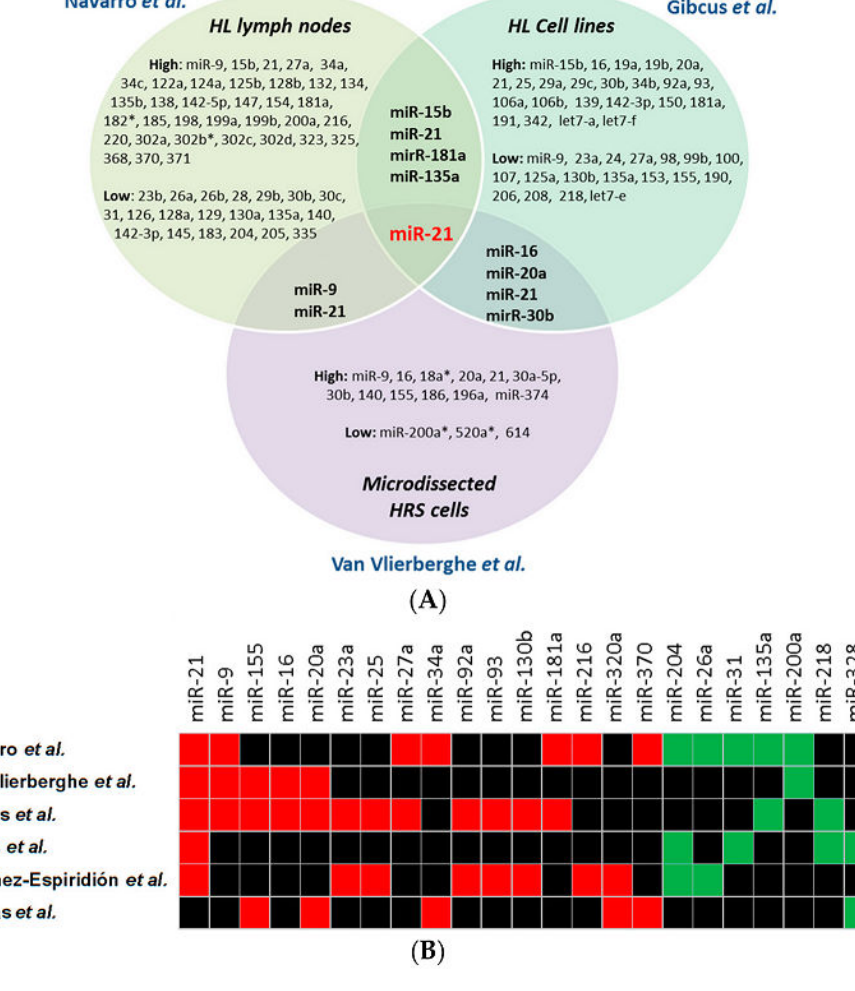
Figure 1. miRNA signatures in HL. ( A ) Venn diagram with the first three signatures reported in HL: one in lymph nodes [23]; one in cell lines [26]; and one in microdissected HRS cells [25]; and ( B ) overlapping miRNAs in the six HL profile studies. Only the miRNAs shared by at least two signatures and with the same expression are included. Red boxes indicate overexpressed and green underexpressed miRNAs. Black boxes indicate miRNAs not included in the list. More detailed information is included in Table